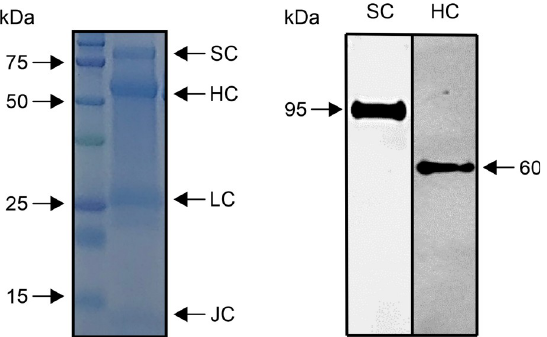
Fig 2. Characterization of purified saliva. The left panel shows protein bands of various molecular weights separated by SDS-PAGE. These bands were confirmed to correspond to the molecular weight of the secretory component (SC), IgA heavy chain (HC), IgA light chain, and J chain. The right panel shows the specific signals of SC and HC determined by western blotting.